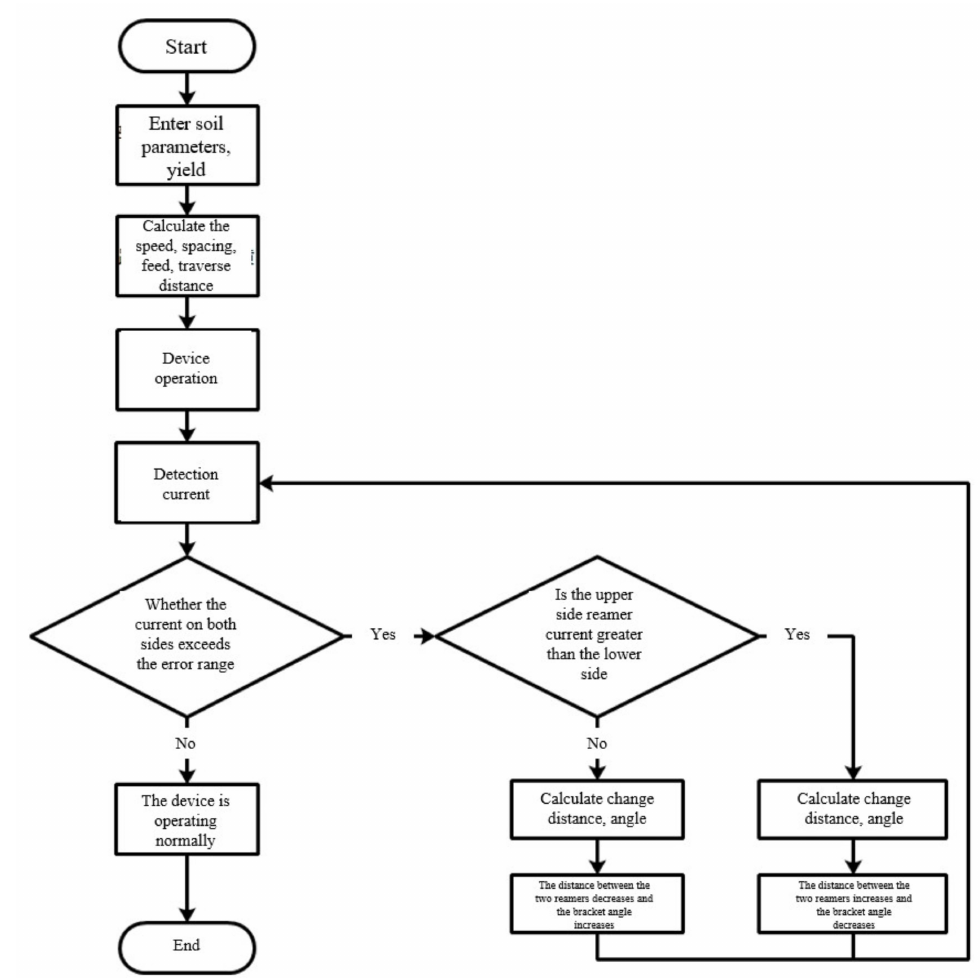
Figure 10. Adaptive control